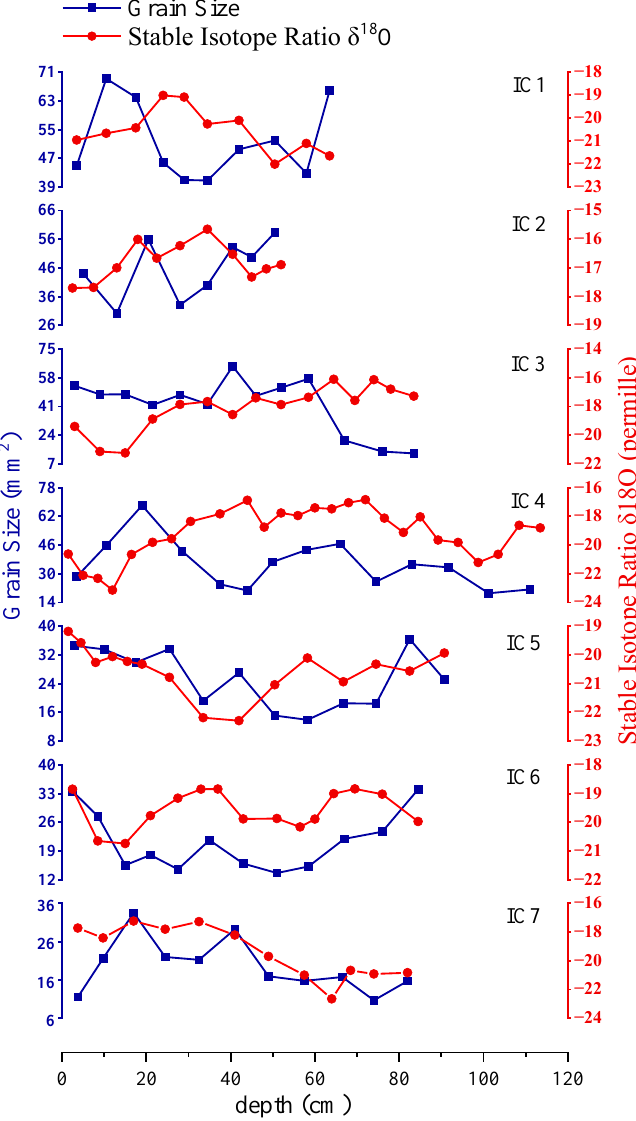
Figure 11. Correlations between ice grain sizes and stable water isotope δ 18 O.